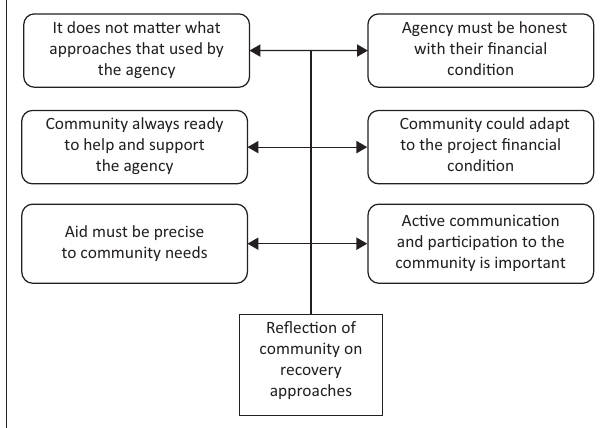
FIG URE 6: Community reflection on the recovery approaches in Loli Dondo Village.